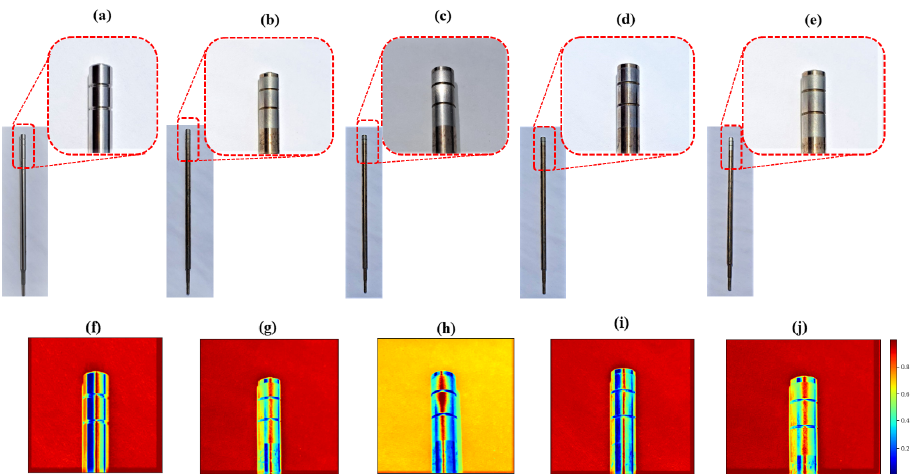
Figure A1. Comparison of injector valve pistons between ( a ) normal injector, ( b – e ) the worn injectors after the experiment, and ( f – j ) the surface profiles for the respective injector valve pistons.